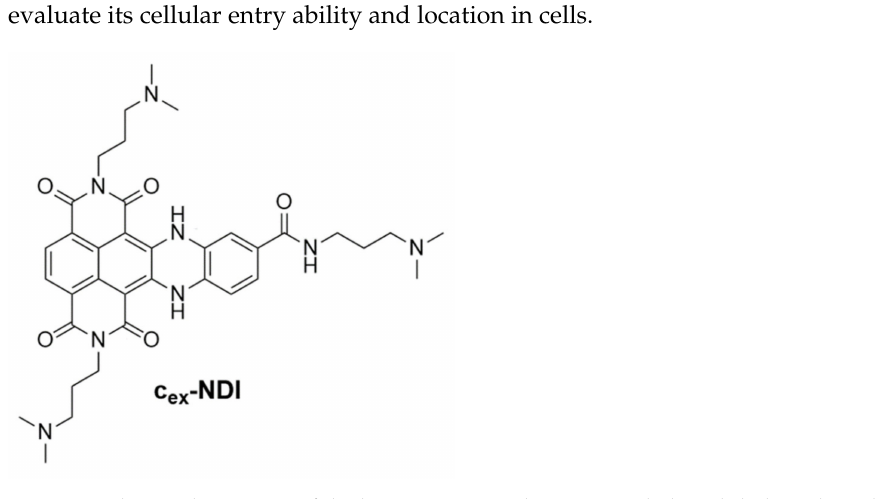
Figure 1. Chemical structure of the here investigated core-extended naphthalene diimide c ex -NDI